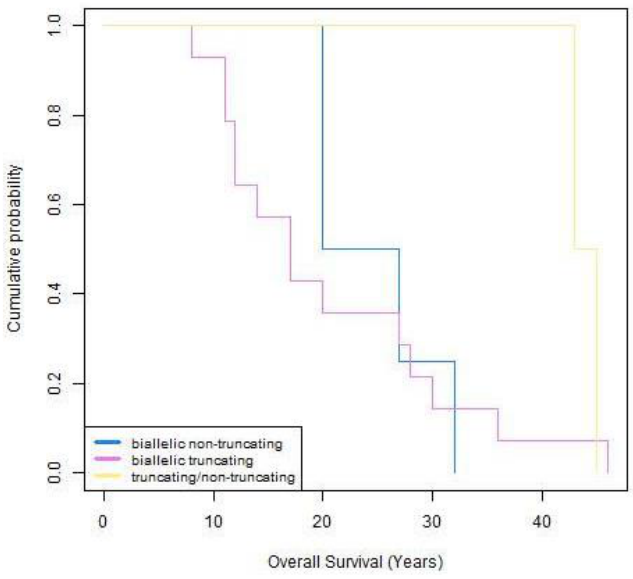
Figure 4. Kaplan – Meier analysis of patients with bi-allelic desmin variants. The curve is based on the patients so far reported in literature, including our patient. The violet line represents patients carrying bi-allelic truncating variants, the light blue line patients carrying bi-allelic non truncating variants while the yellow line patients with bi-allelic truncating/non truncating variants in compound heterozygosity.